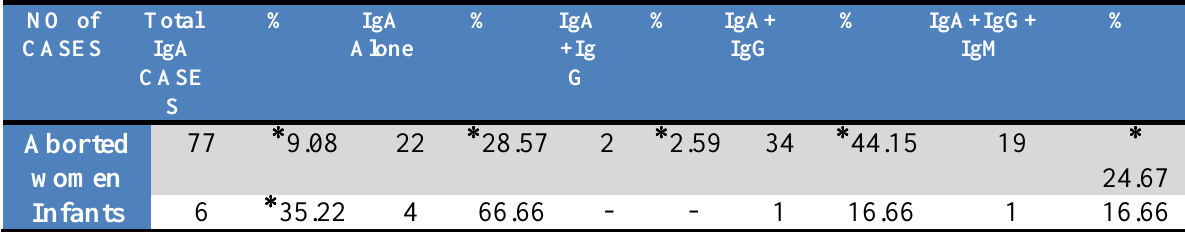
Table (3).Detection of IgA anti Toxoplasma gondii in association with IgM and IgG in aborted women and infants sera .